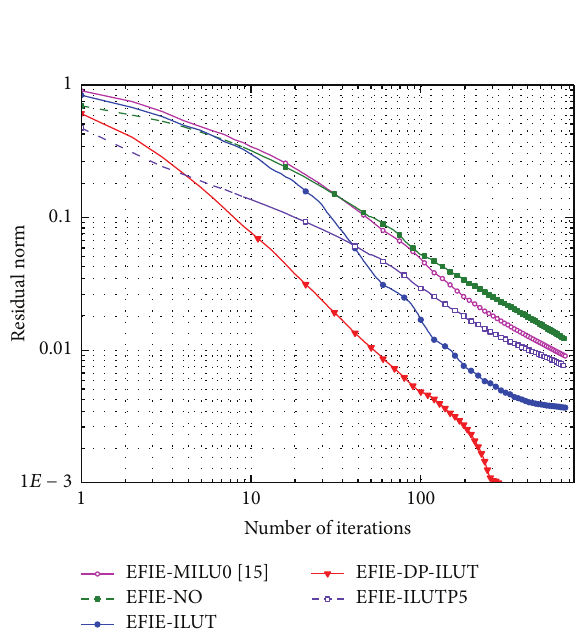
Figure 7: The convergence history of GMRES algorithms with differentintegraloperatorsandpreconditionersintheaircraftmodel example.